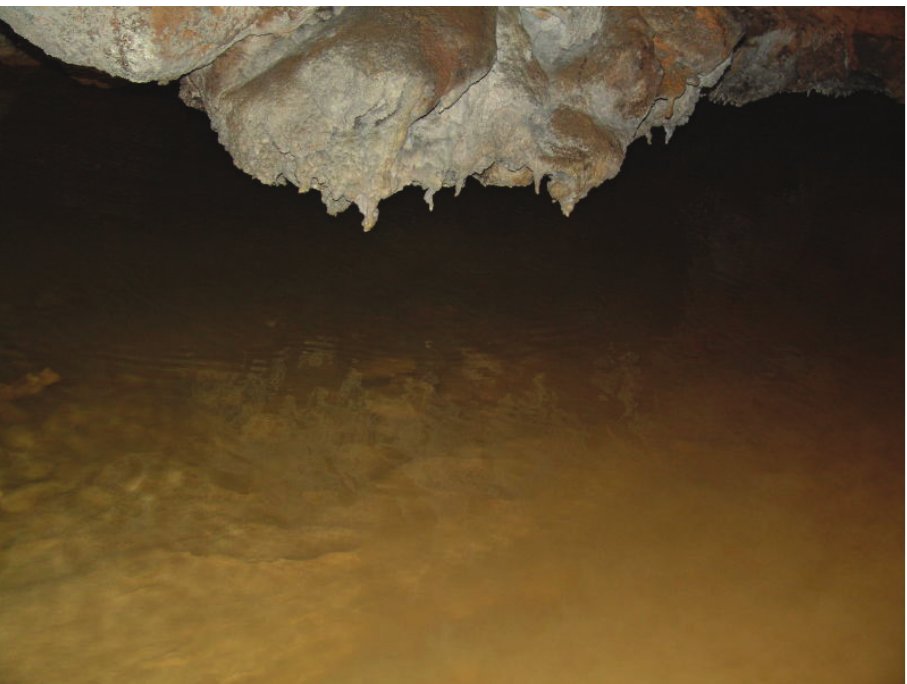
Figure 2. Type locality of Triplophysa anshuiensis sp. n., a cave in Anshui Village, Guangxi, China.